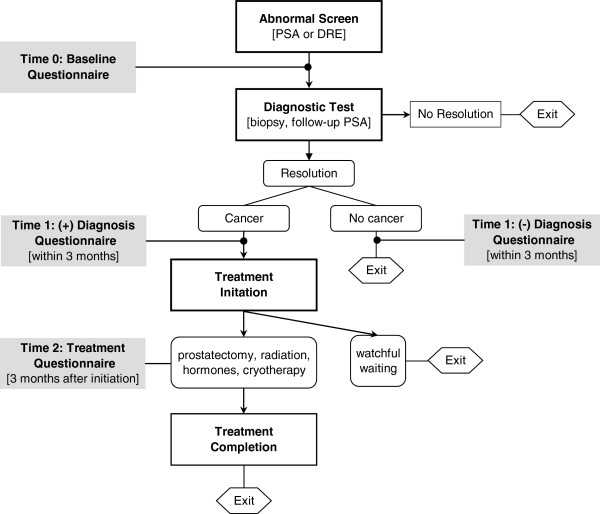
Study flow chart. Men were enrolled following referral for either an abnormal prostate specific antigen or digital rectal screening test and navigated through diagnostic resolution for patients without prostate cancer, treatment completion for those with prostate cancer, or end of study. Questionnaires were administered at baseline, within 3 months of diagnosis, and 3 months after treatment initiation to navigated subjects and a subsample of controls.